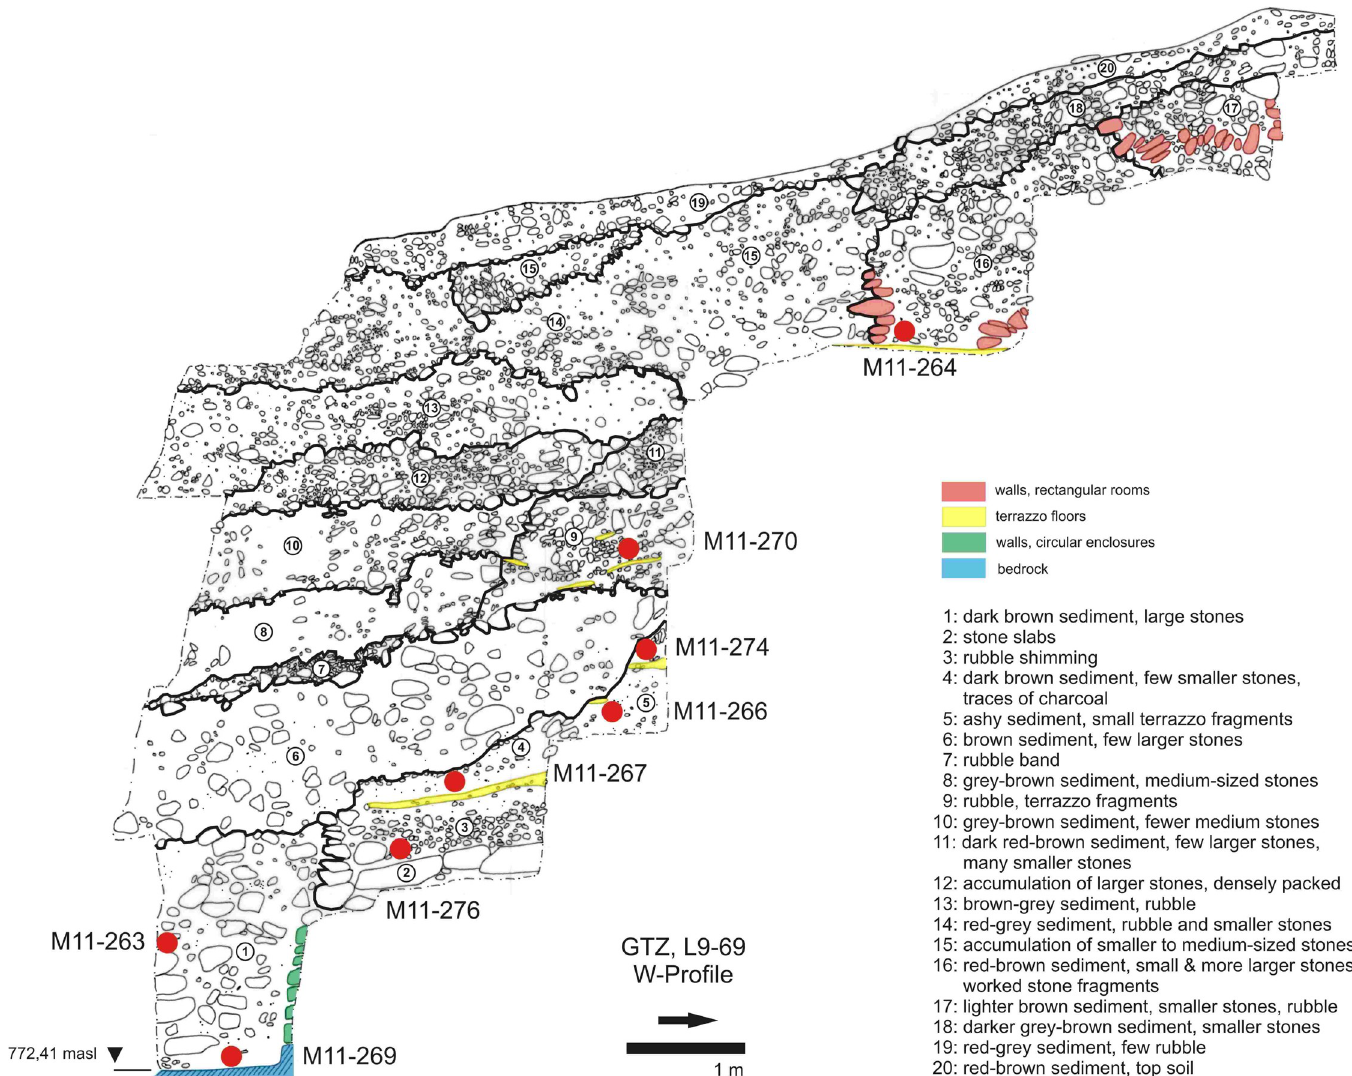
Fig 4. Stratigraphy of Go¨bekli Tepe. Western profile of area L9-69 in the main excavation area showing several terrazzo floors in layer II and the second ring wall of building D as well as the origin of tested soil samples (German Archaeological Institute, compilation J. Notroff).